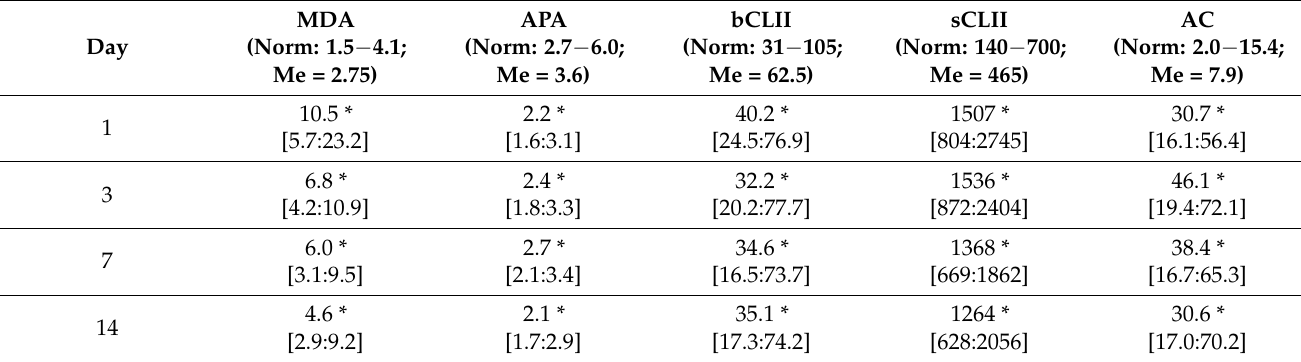
Figure 8. Dynamics of the AC indicator. Table 8. Dynamics of FRP